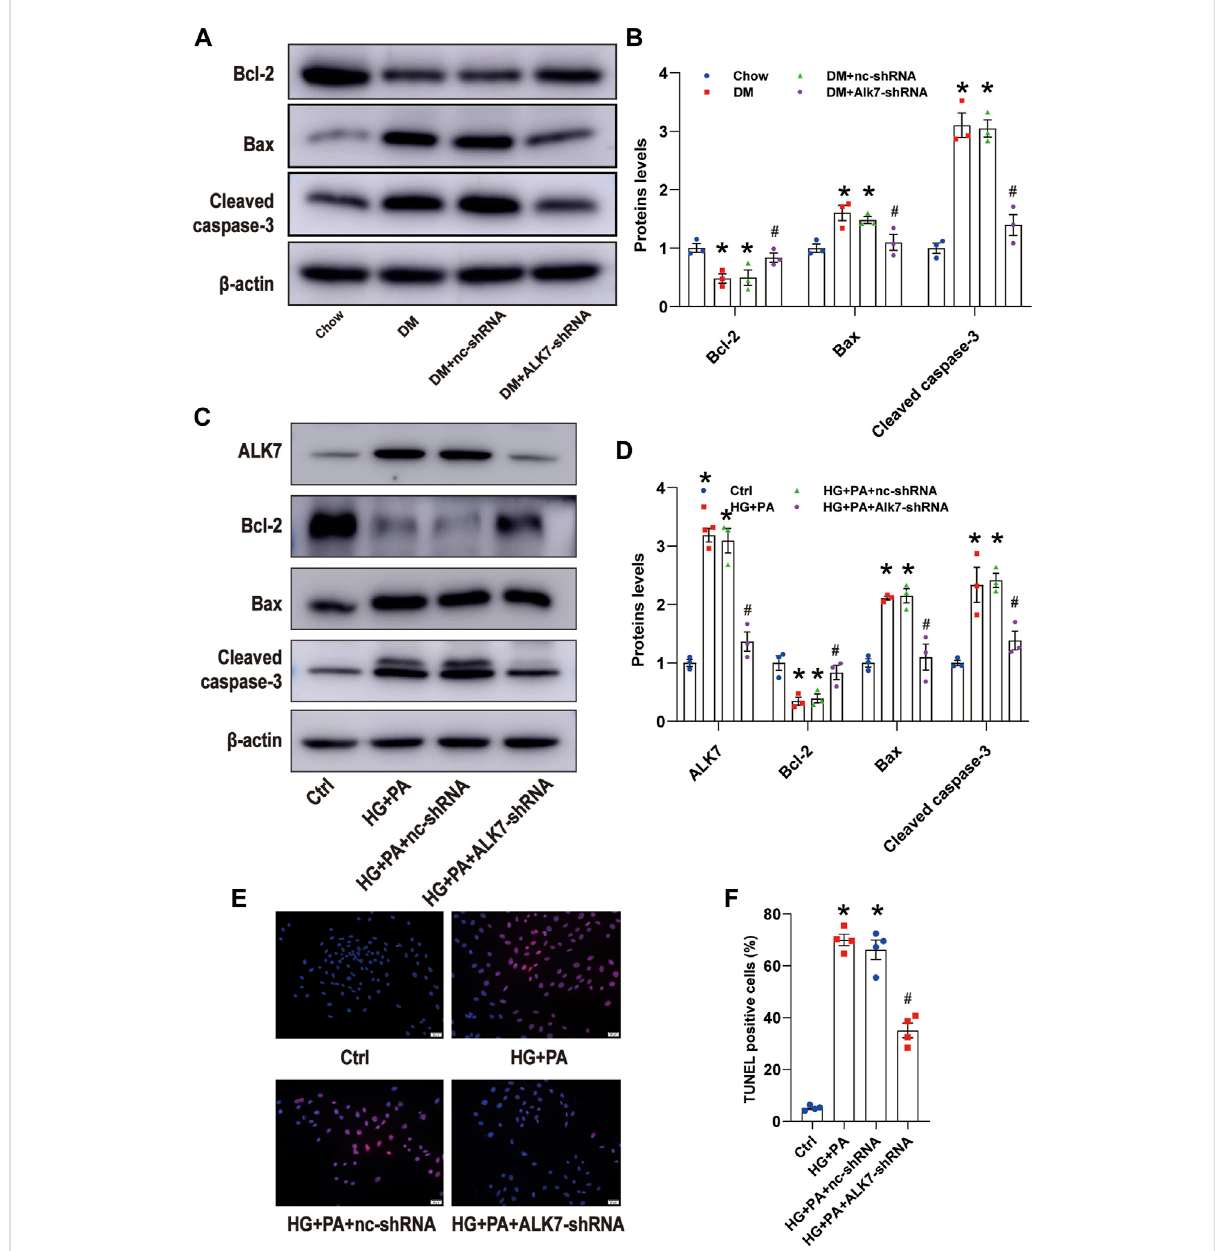
FIGURE 4 Knockdown of ALK7 inhibited VSMC apoptosis in the atherosclerotic plaques of diabetic mice. (A – B) . The protein level of Bcl-2, Bax, and cleaved caspase 3 in the aortas with atherosclerotic plaques of diabetic mice were determined by western blot. n = 3 per group. * p < 0.05 vs. the Chowgroup, # p < 0.05vs.theDM+nc-shRNAgroup. (C – D) .TheproteinlevelofBcl-2,Bax,andcleavedcaspase3inVSMCsco-treatedwithHGand PA with or without ALK7-shRNA were determined by western blot. n = 3 per group. * p < 0.05 vs. the control group, # p < 0.05 vs. the HG + PA + nc-shRNA group. (E – F) . The percentage of VSMC apoptosis treated by co-treatment of HG and PA with or without ALK7-shRNA was determined by TUNEL assay. n = 4 per group. Scale bar: 20 μ m. The control group was added with 5.5 mM glucose, 19.5 mM mannose and 0.4 mM BSA. * p < 0.05 vs. the control group, # p < 0.05 vs. the HG + PA + nc-shRNA group. Data was analyzed with